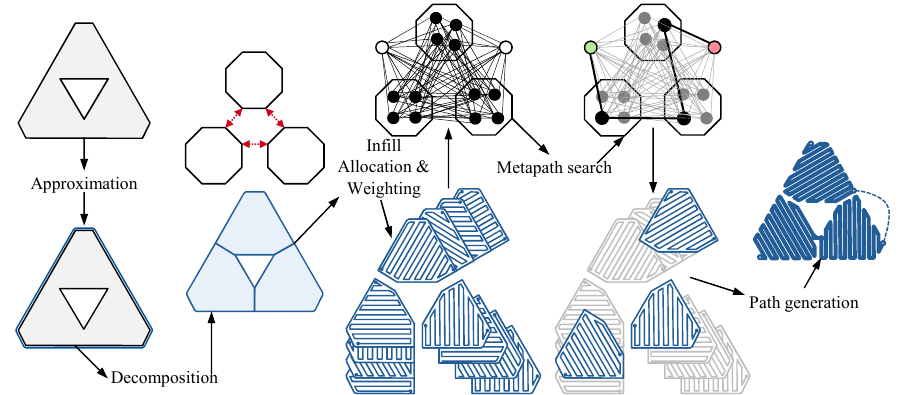
Figure 6. Decomposition path planning algorithm for MDAM.